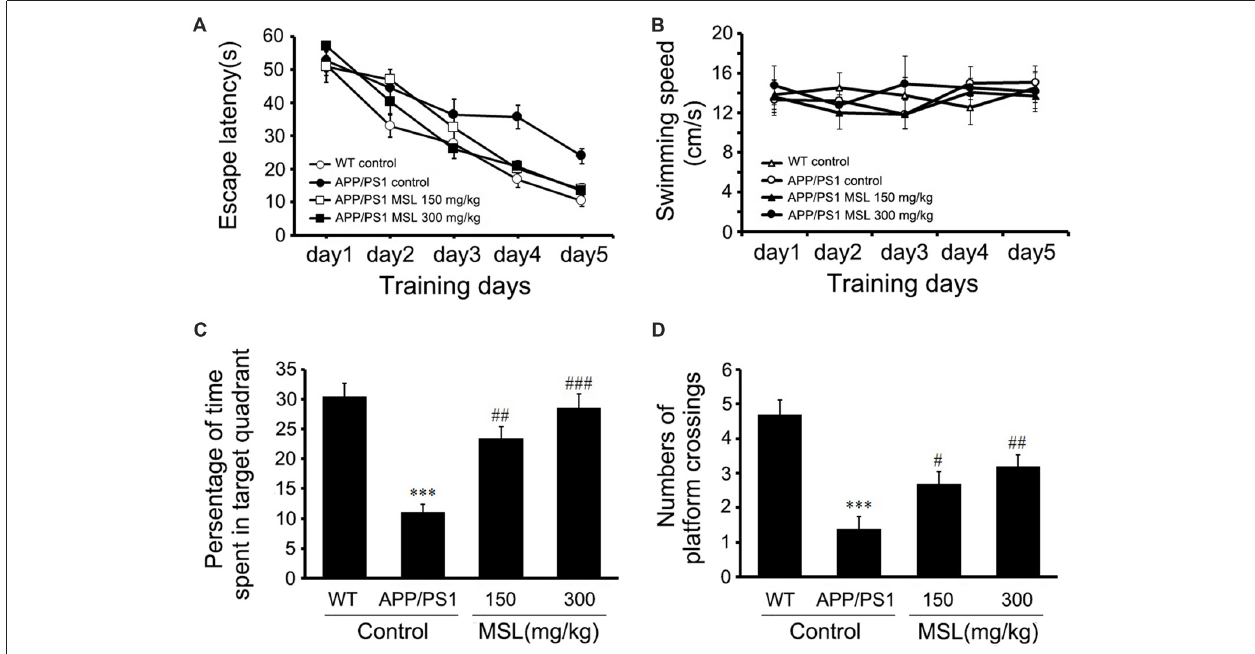
FIGURE 1 | Methyl salicylate lactoside (MSL) improved learning and memory in amyloid precursor protein (APP)/presenilin 1 (PS1) mice. (A) Latency to reach the escape platform during five training days in the Morris water maze (MWM) test showed a significant effect on escape latency ( F ( 4,144 ) = 117.763, p < 0.001) between groups. (B) During the training period, no significant differences were observed in swimming speed of mice among groups. (C) In the probe test, MSL-treated mice showed a significant increase in the time spent in the target quadrant when compared to the APP/PS1 control mice. (D) In the probe test, MSL-treated mice showed an increase in the number of platform crossings when compared to APP/PS1 control mice. Data are presented as the mean ± SEM, n = 12 mice per group. ∗∗∗ p < 0.001 vs. wild-type (WT) control mice; # p < 0.05, ## p < 0.01, ### p < 0.001 vs. APP/PS1 control